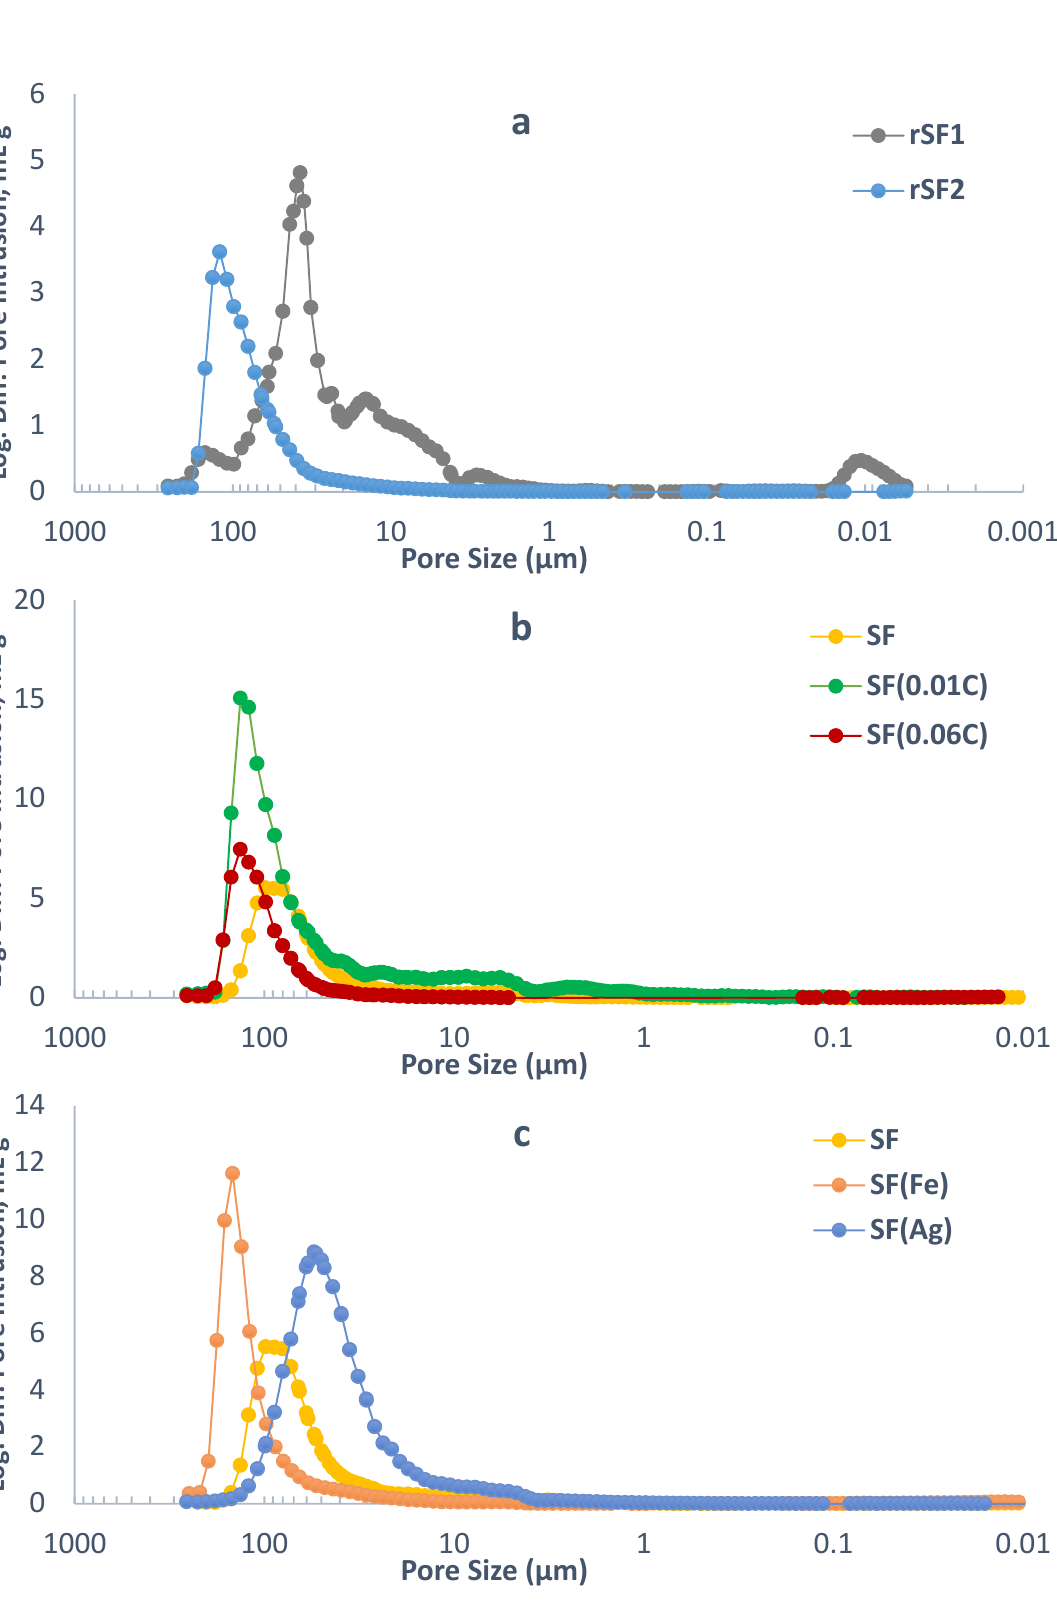
Figure 9. Pore size distribution of: ( a ) carbon foams rSF1 and rSF2 obtained by pressurized foaming; ( b ) carbon foams SF, SF(0.01C) and SF(0.06C) obtained by foaming under atmospheric pressure, and ( c ) carbon foams SF, SF(Fe) and SF(Ag) obtained by foaming under atmospheric pressure.